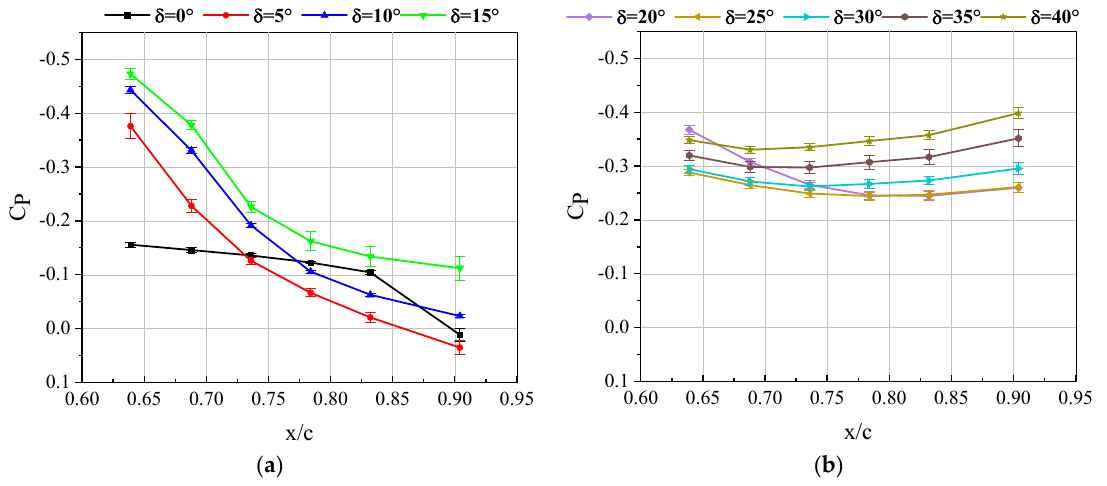
Figure 8. Rudder pressure distribution at different deflection angles: ( a ) δ = 0°~15°; ( b ) δ = 20°~40° ( β = 0°, Re = 2.12 × 10 5 ).